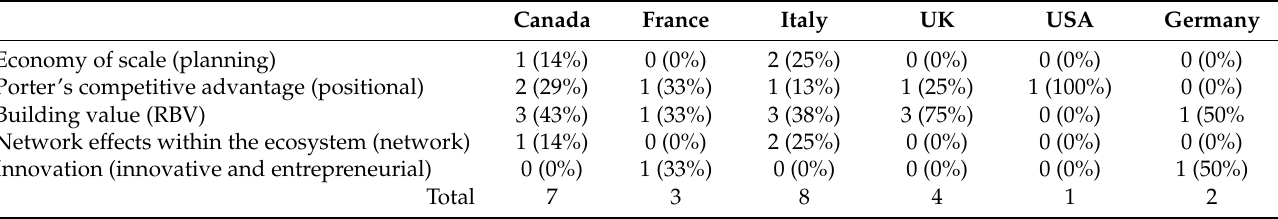
Table 9. Percentages of the indicator of achieved rents (% GDP).